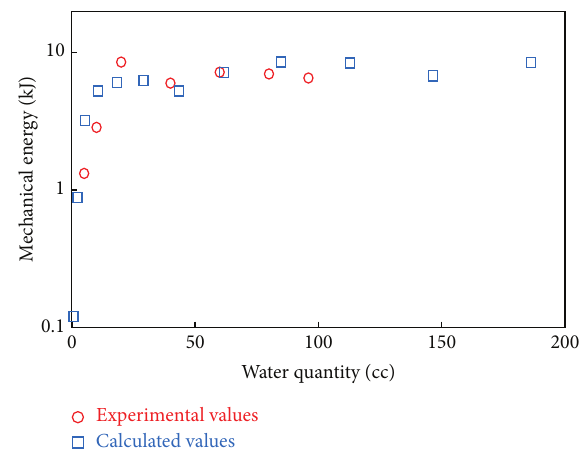
Figure 12: Experimental and calculated mechanical energy release at varying water quantities.